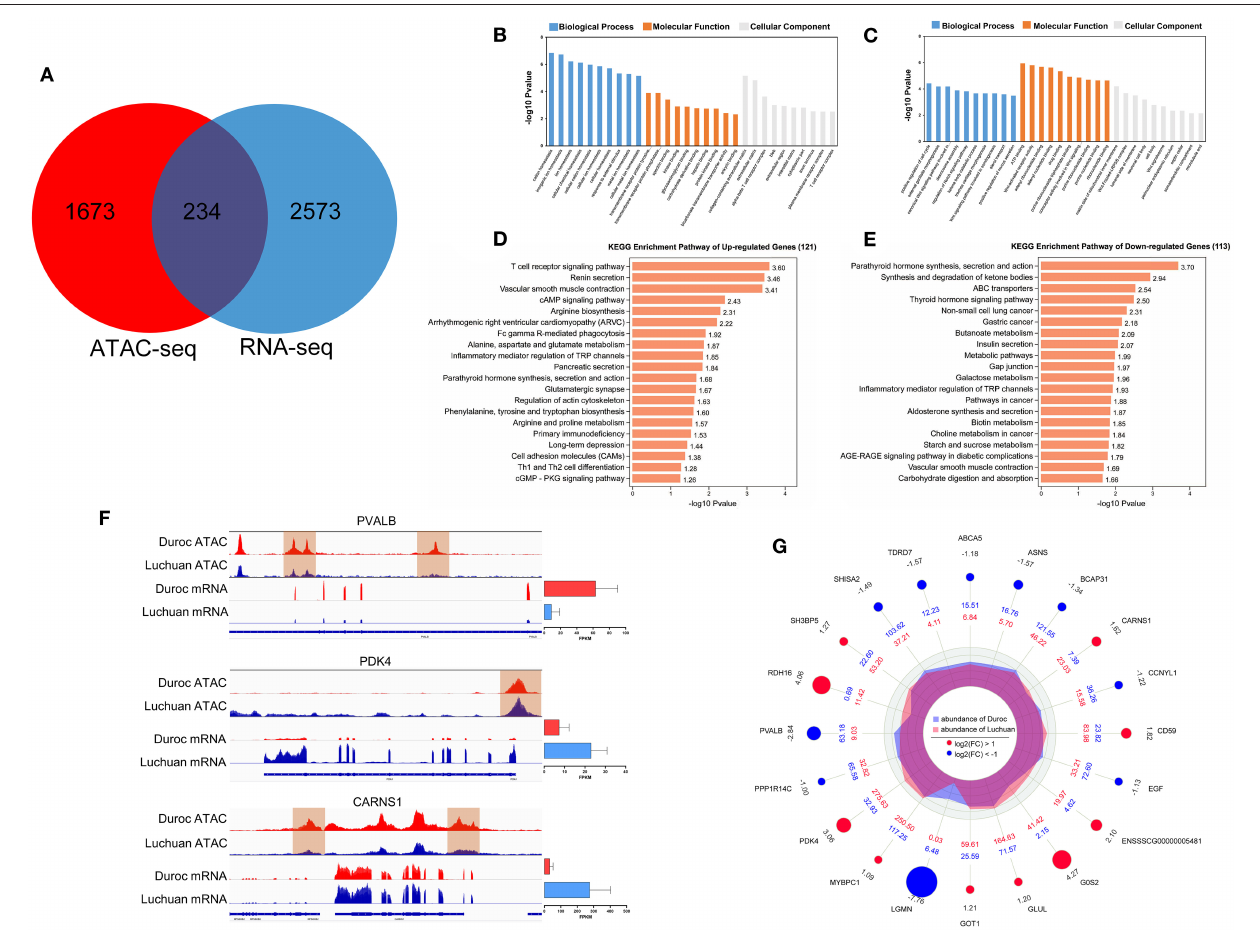
FIGURE 5 | Analysis results of integrated ATAC-seq and RNA-seq results. (A) Intersection of different mRNAs and different peaks corresponding to the target genes. (B) GO enrichment of upregulated DEGs. (C) GO enrichment of downregulated DEGs. (D) KEGG classification of upregulated DEGs. (E) KEGG classification of downregulated DEGs. (F) Peak diagram showing the relationship between genes in open regions of chromatin and gene expression. Among them, the PVALB gene of Duroc had a different peak and its transcriptional expression level was high; the PDK4 gene of Luchuan had a different peak and its transcriptional expression level was high; the CARNS1 gene of Duroc had different peaks but its transcriptional expression level was low. (G) A radar map of the top 20 candidate genes.